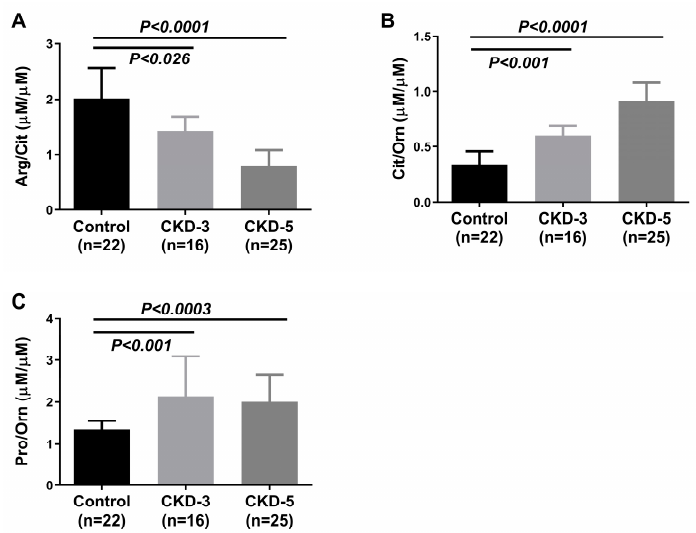
Figure 4. Plasma ratio of amino acids in control and CKD stages-3 and -5. ( A ) Arg/Cit, ( B ) Cit/Orn and ( C ) Pro/Orn ratios between control (n = 22), CKD-3 (n = 16) and CKD-5 (n = 25) groups, respectively. Data are expressed as median (interquartile range); significances were assessed by Mann–Whitney U-test. The significant differences were p < 0.0001 for Arg/Cit and Cit/Orn between control vs. CKD-5, p < 0.001 for Cit/Orn and Pro/Orn between control vs. CKD-3, p < 0.026 for Arg/Cit between control vs. CKD-3 and p < 0.0003 for Pro/Orn between control vs. CKD-5, respectively. The concentration of arginine, citrulline, ornithine and proline were measured using chromatographic separation, and the ratios of Arg/Cit, Cit/Orn and Pro/Orn were calculated from the measured concentration. Arg = arginine; Cit = citrulline; Pro = proline; Orn = ornithine; CKD-3 = chronic kidney disease stage 3; CKD-5 = chronic kidney disease stage 5.